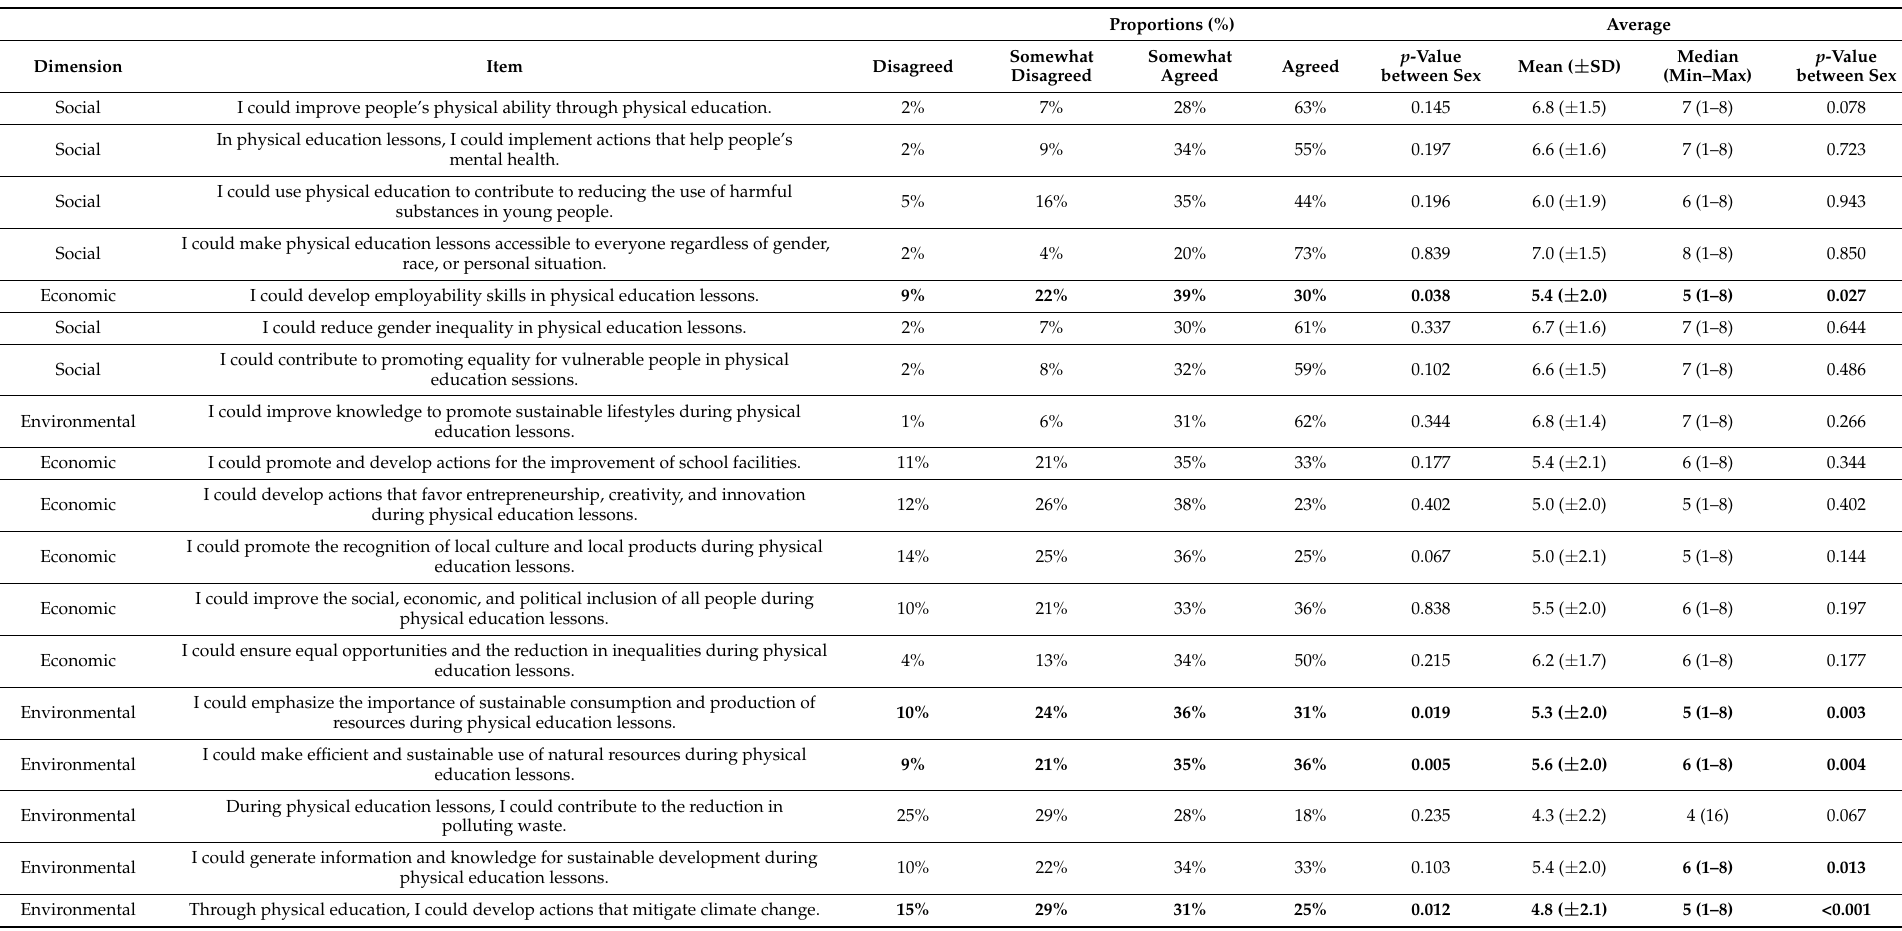
Table 2. Distribution of proportions, mean and median values for each of the 18 items in the PESD-FT in the total sample (n = 1153). Item Disagreed Somewhat Disagreed Somewhat Agreed Agreed